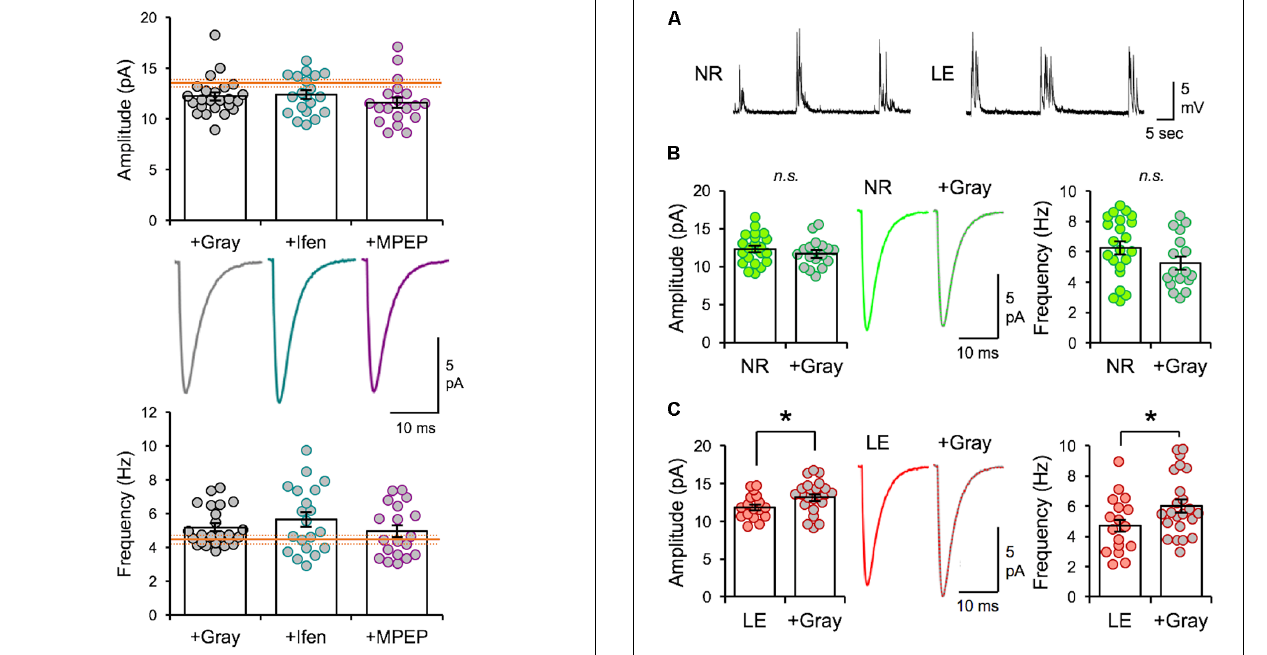
FIGURE 5 | Naturalistic pattern stimulation-induced synaptic depression is not dependent on GluN2B-containing NMDARs or mGluR5s. Stimulation with +Gray activity while blocking GluN2B-containing NMDARs with ifenprodil (+Ifen) or mGluR5s with MPEP (+MPEP) did not yield significantly different changes from stimulation with +Gray alone. Top: average mEPSC amplitudes of individual neurons are shown as circles and mean ± S.E.M are shown as bars (DE+Gray = 11.93 ± 0.28 pA; DE+Gray+Ifen = 12.36 ± 0.42 pA; DE+Gray+MPEP = 11.6 ± 0.51 pA; ANOVA, F = 0.8522, p = 0.4317). For reference, the mean mEPSC amplitude for DE is shown as the orange line with ± S.E.M. shown in dotted orange lines. Middle: average mEPSC traces for each group. Bottom: average mEPSC frequency comparison across groups (DE+Gray median = 4.753 Hz; DE+Gray+Ifen median = 5.258 Hz; DE+Gray+MPEP median = 4.454Hz; ANOVA, F = 1.076, p = 0.3475). For reference, the mean mEPSC frequency for DE is shown as the orange line with ± S.E.M. shown in dotted orange lines.